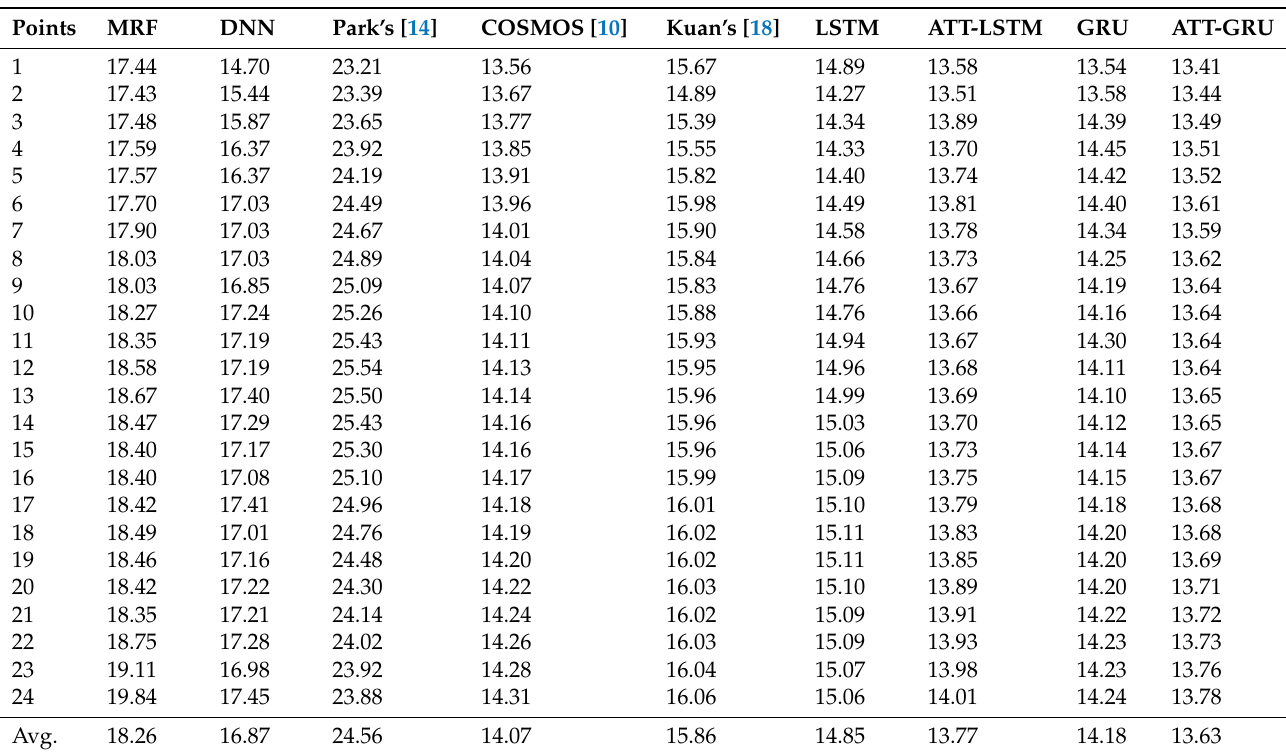
Table A1. Mean absolute percentage error comparison for Building 1.